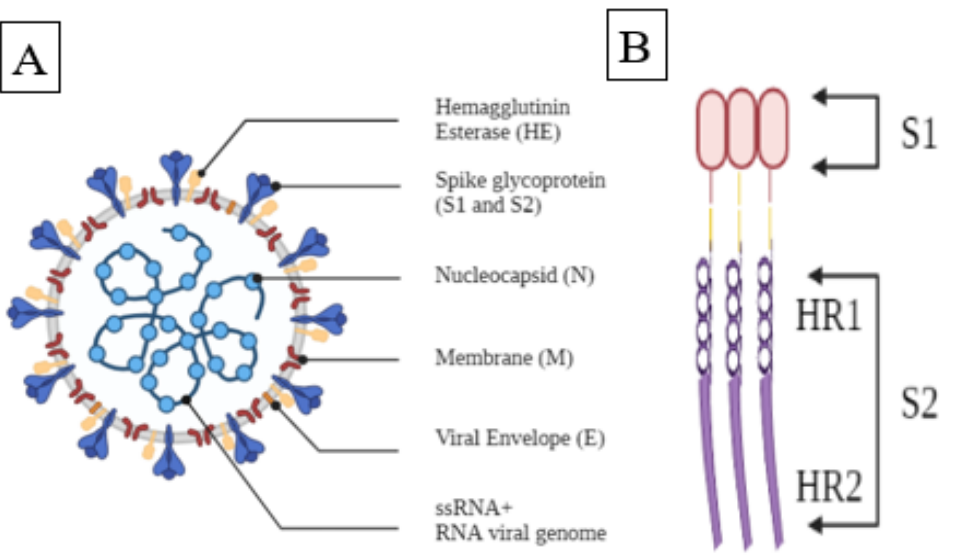
Figure 1. ( A ). Structure of SARS-CoV-2, ( B ). Spike protein of SARS-CoV-2 .